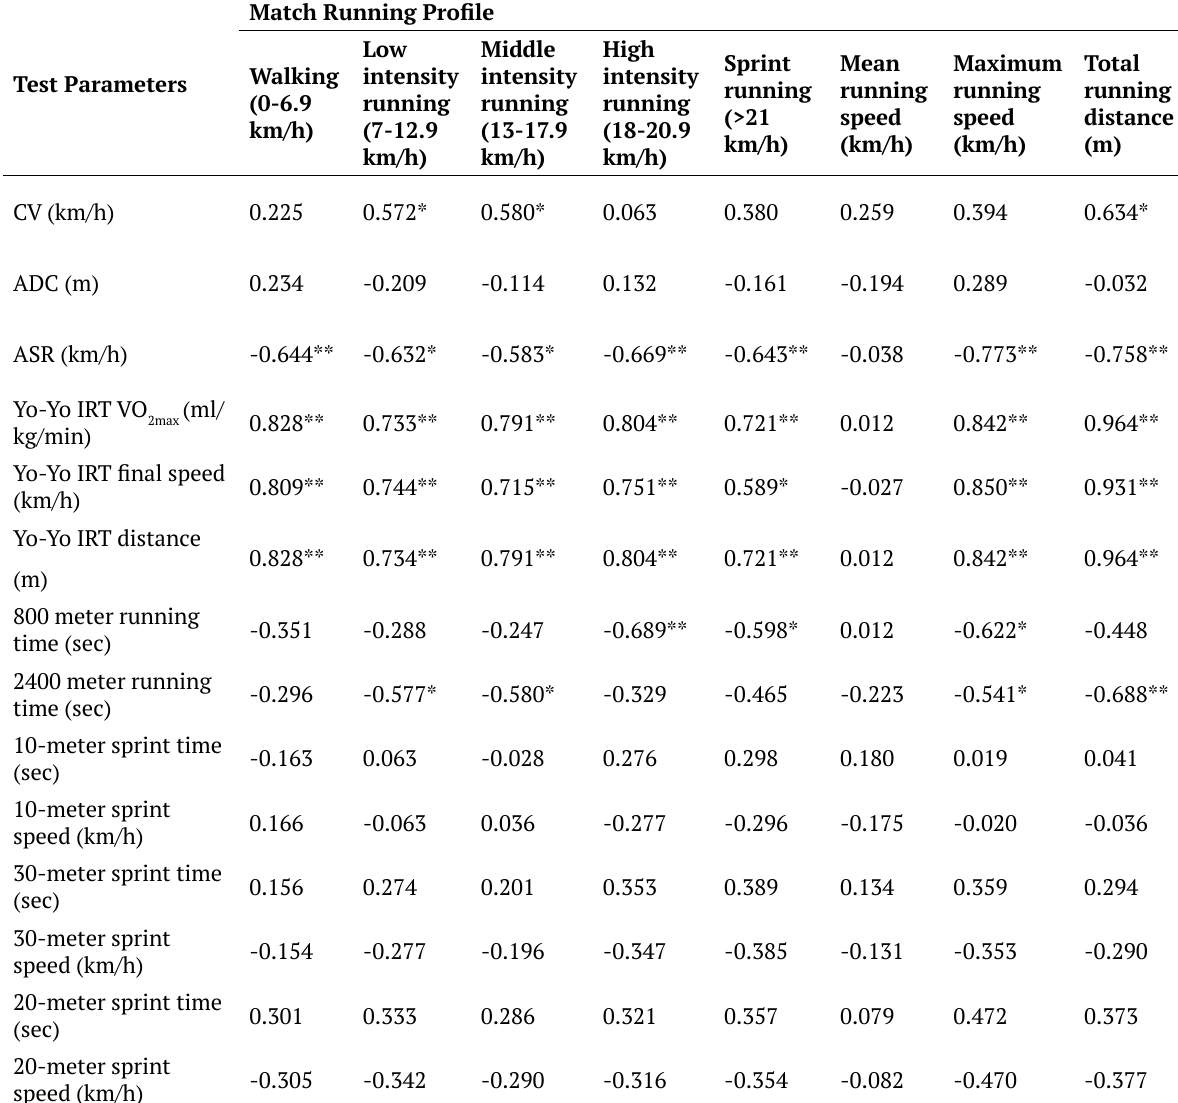
Table 3. Correlation Coefficients between Match Running Profile and Test Parameters (n=15)